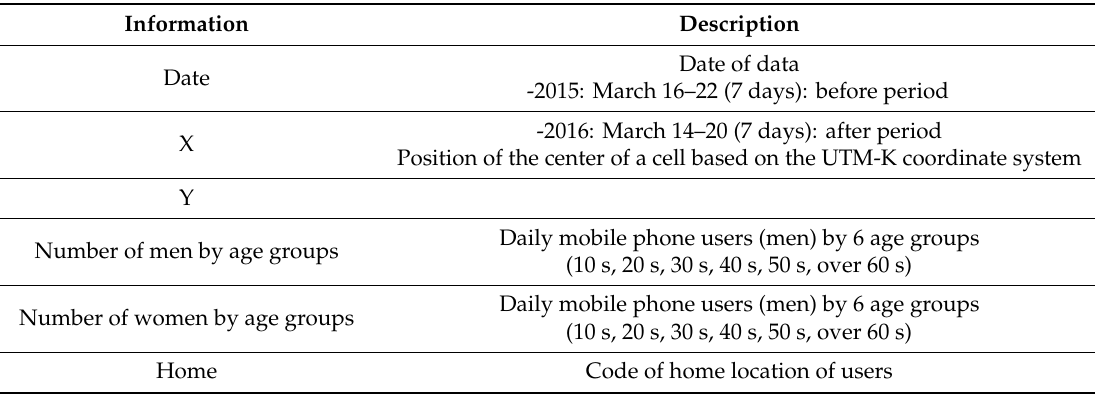
Table 2. Mobile Phone Data Structure.